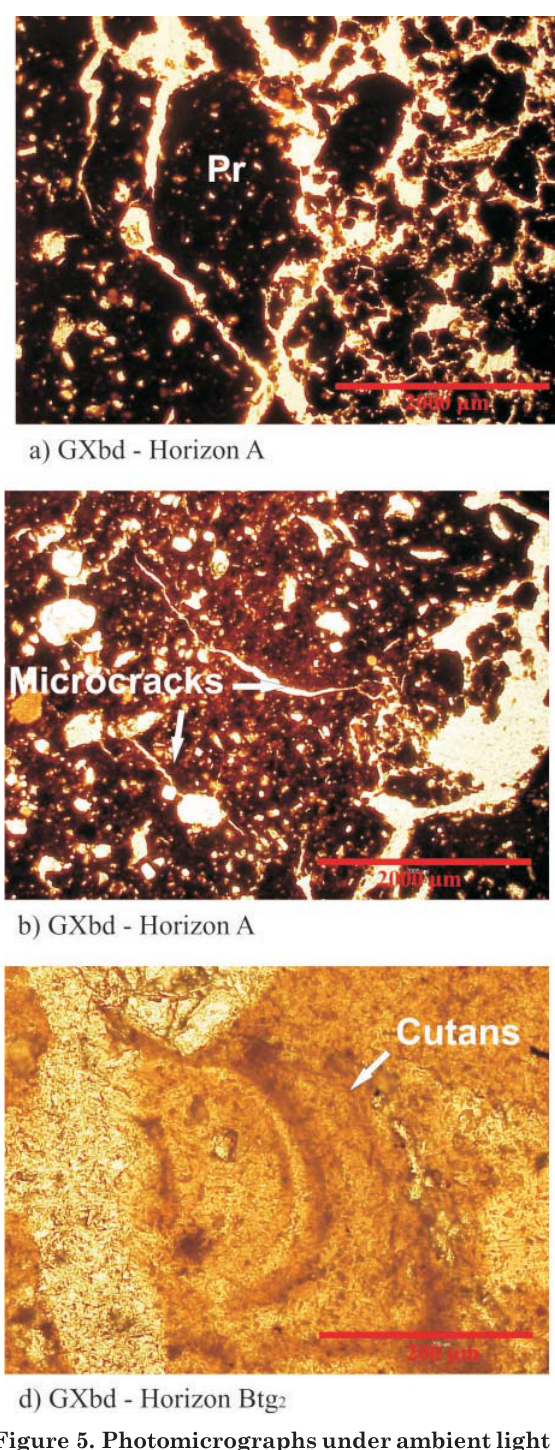
Figure 5. Photomicrographs under ambient light of GXbd horizons: (a) A horizon of the GXbd with prismatic microstruture (Pr); (b) presence of microfissures in the A horizon of the GXbd; (c) horizon of the GXbd. illuvial cutans in the Btg 2